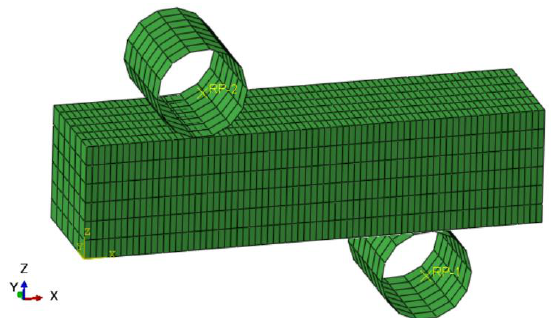
Figure 11. The discretized finite element model of the four-point bend test (1/2 model).